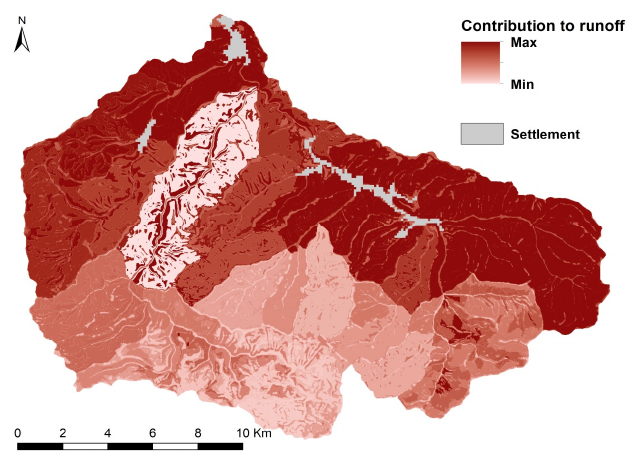
Figure 5. Contribution of the hydrologic response units (HRUs) to the total runoff.